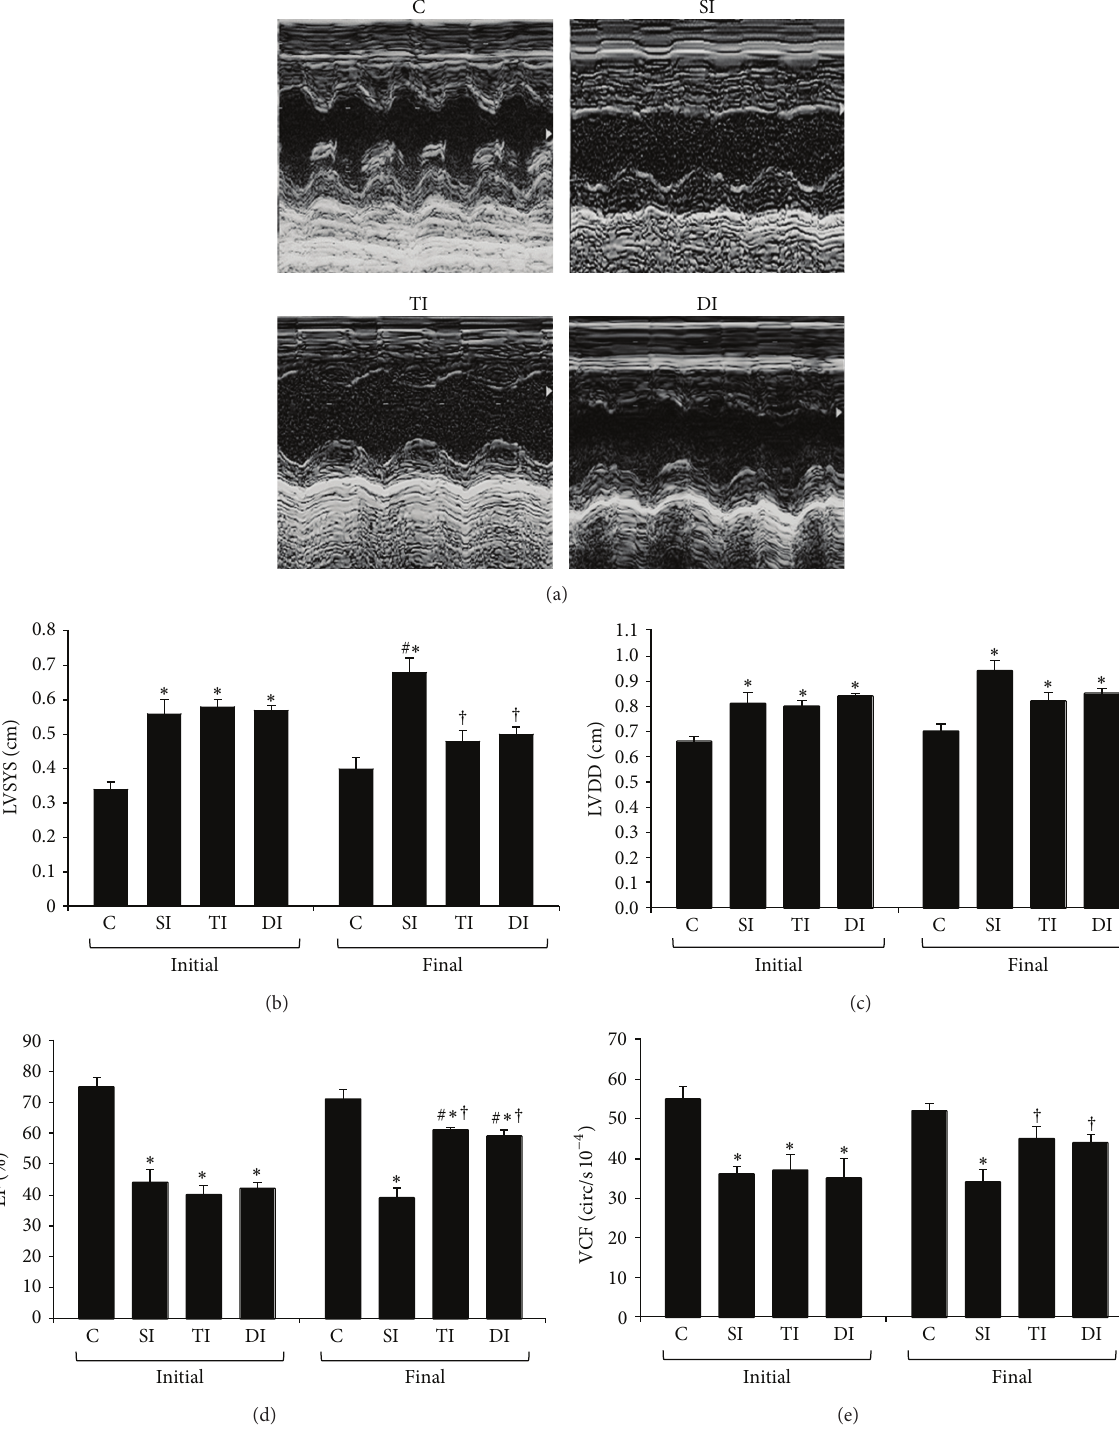
Figure 1: Echocardiographic assessment of LV function. (a) Representative M-mode echocardiographic images. (b) LV internal diameter in systole(LVSYS).(c)LVinternaldiameterindiastole(LVDD).(d)Ejectionfraction(EF).(e)Velocityofcircumferentialfibershortening(VCF). Quantitative echocardiographic parameters were evaluated in control (C), sedentary infarcted (SI), trained infarcted (TI), and detrained infarcted (DI) rats. # 𝑃 < 0.05 versus initial evaluation in the same group; ∗ 𝑃 < 0.05 versus C; † 𝑃 < 0.05 versus